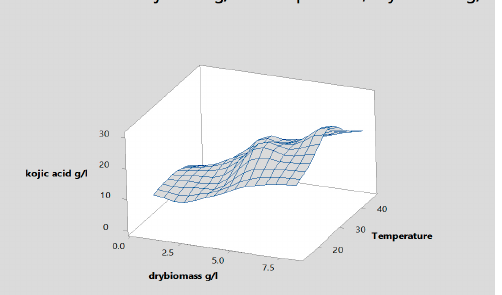
Fig. 5. Effect of incubation temperature on kojic acid production, drymass and consumption of sugar by A.flavus